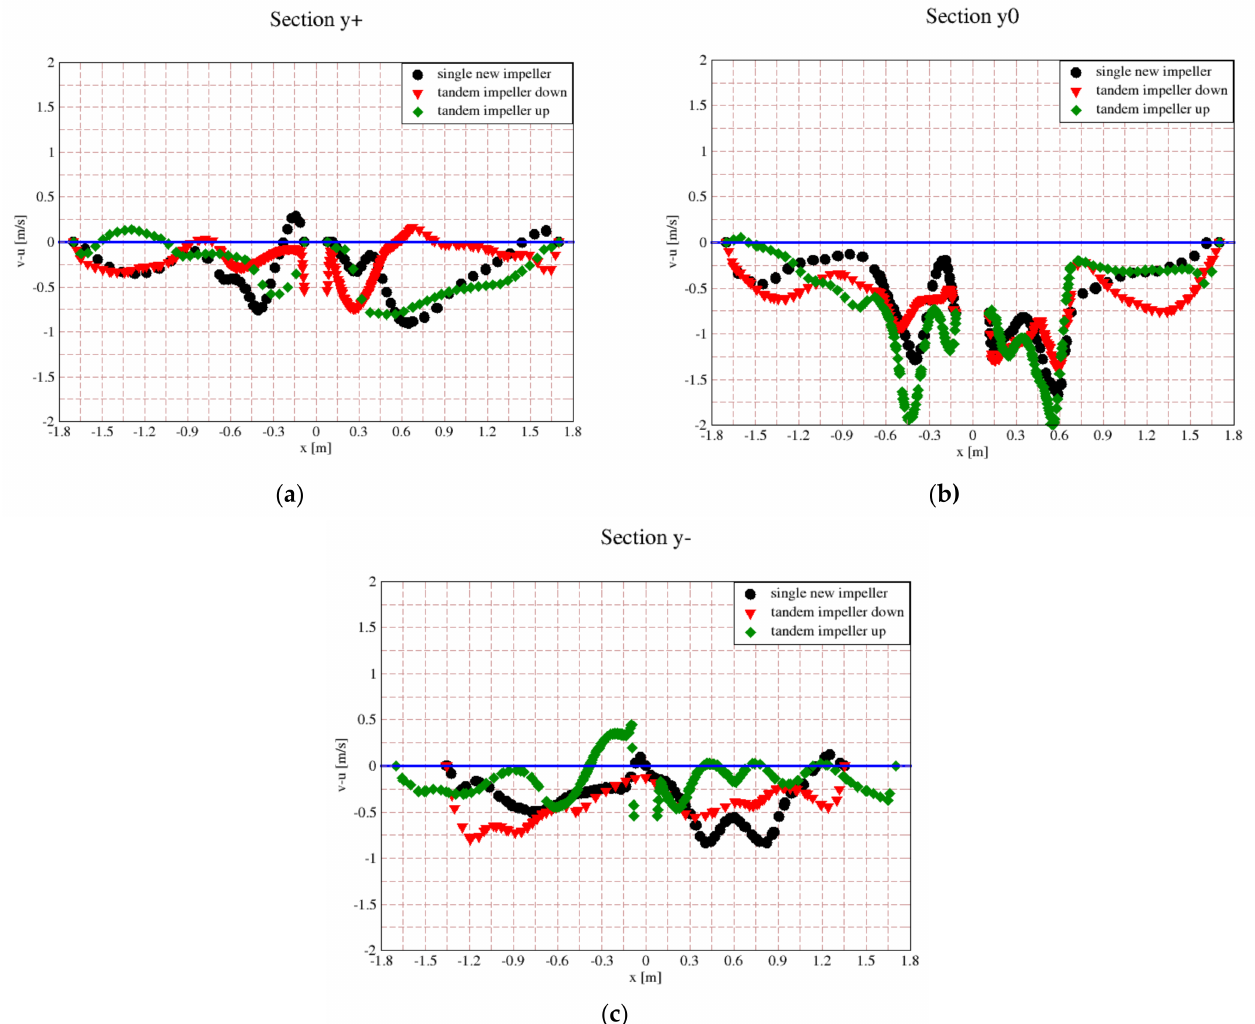
Figure 9. Tangential velocity distribution of liquid phase at various axial levels, single new impeller vs. new impellers in tandem, instantaneous results: ( a ) above impeller; ( b ) impeller level; ( c ) under